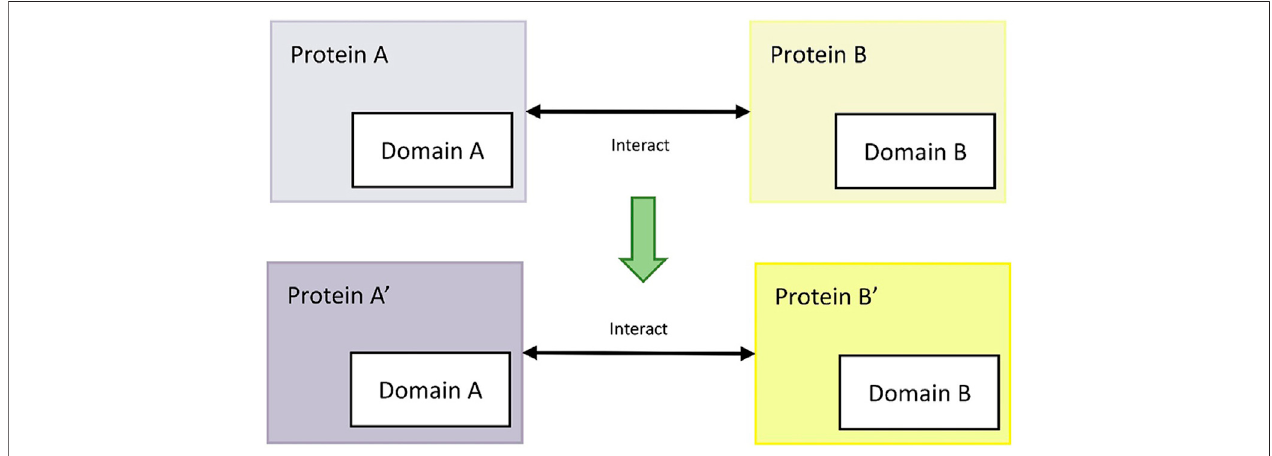
FIGURE 5 | Domain-domain